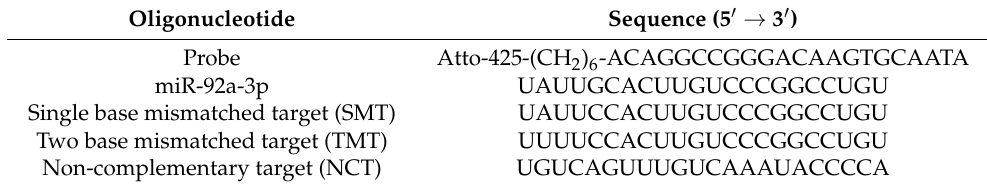
Table 1. The oligonucleotide sequences used in this work. Oligonucleotide